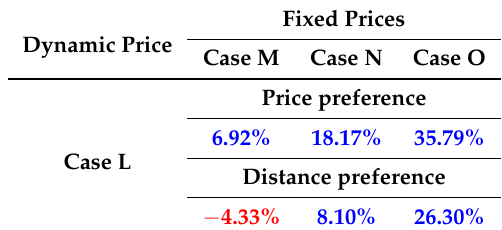
Table 14. Average charge price differences between dynamic Case L and the homologous fixed cases. The average prices paid by the EV users when Case L was used were 0.1867 e /kWh and 0.2178 e /kWh for the user price preference scenario and the user distance preference scenario, respectively. Blue color means that Case L was advantageous for the EV user, whereas the red color means that Case L is not advantageous for the EV